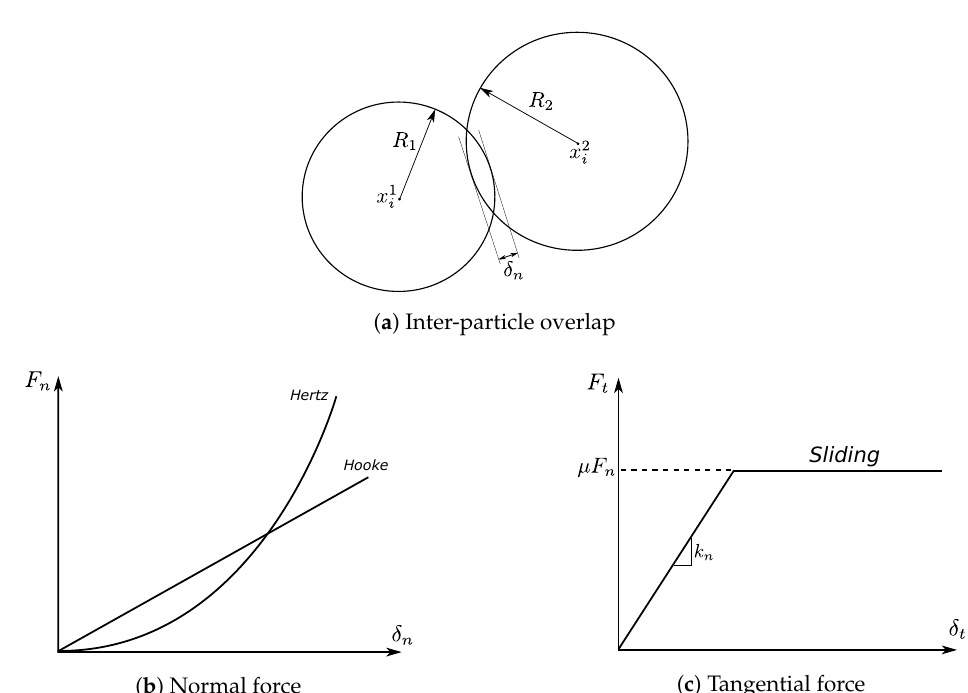
Figure 1. Overlap and inter-particle forces in the Hooke and Hertz contact